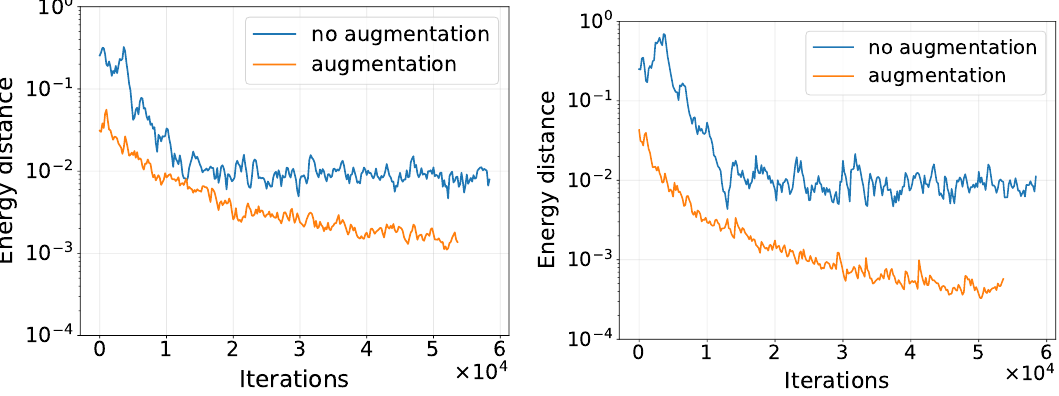
Figure 8 . Energy distance between data and MC features during the training on the left sideband (left) and right sideband (right) for training with and without the augmentation. The corresponding p-value for the chosen model with augmentation at the chosen iteration step was ∼ 0.1 (0.2) for the left (right)